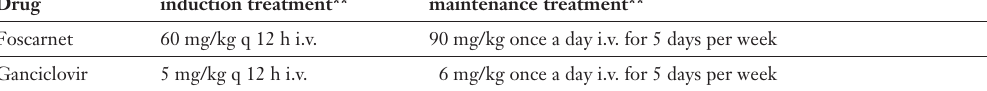
Preemptive treatment regimens for CMV infection after allo- geneic SCT as used in a randomised comparison of foscarnet and ganciclovir